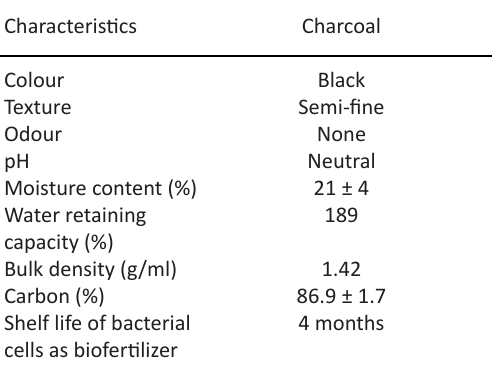
Table 1 . Physicochemical properties of the carrier used in biofertilizer production Characteristics